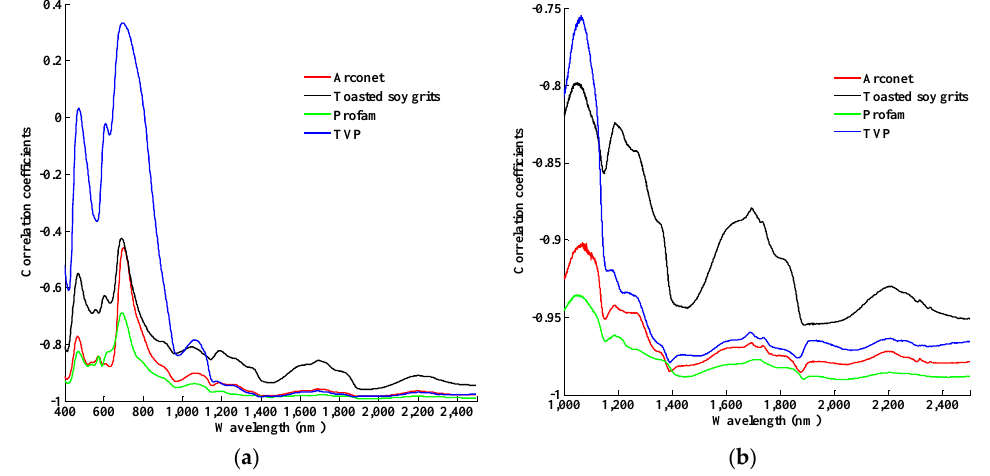
Figure 1. Correlogram between spectral data and mixed soy content classes of soy products in ground beef. ( a ) Dispersive spectral correlogram; ( b ) FT-NIR spectral correlogram, NIR: near-infrared spectroscopy; FT-NIR: Fourier transform NIR; TVP: textured vegetable protein.